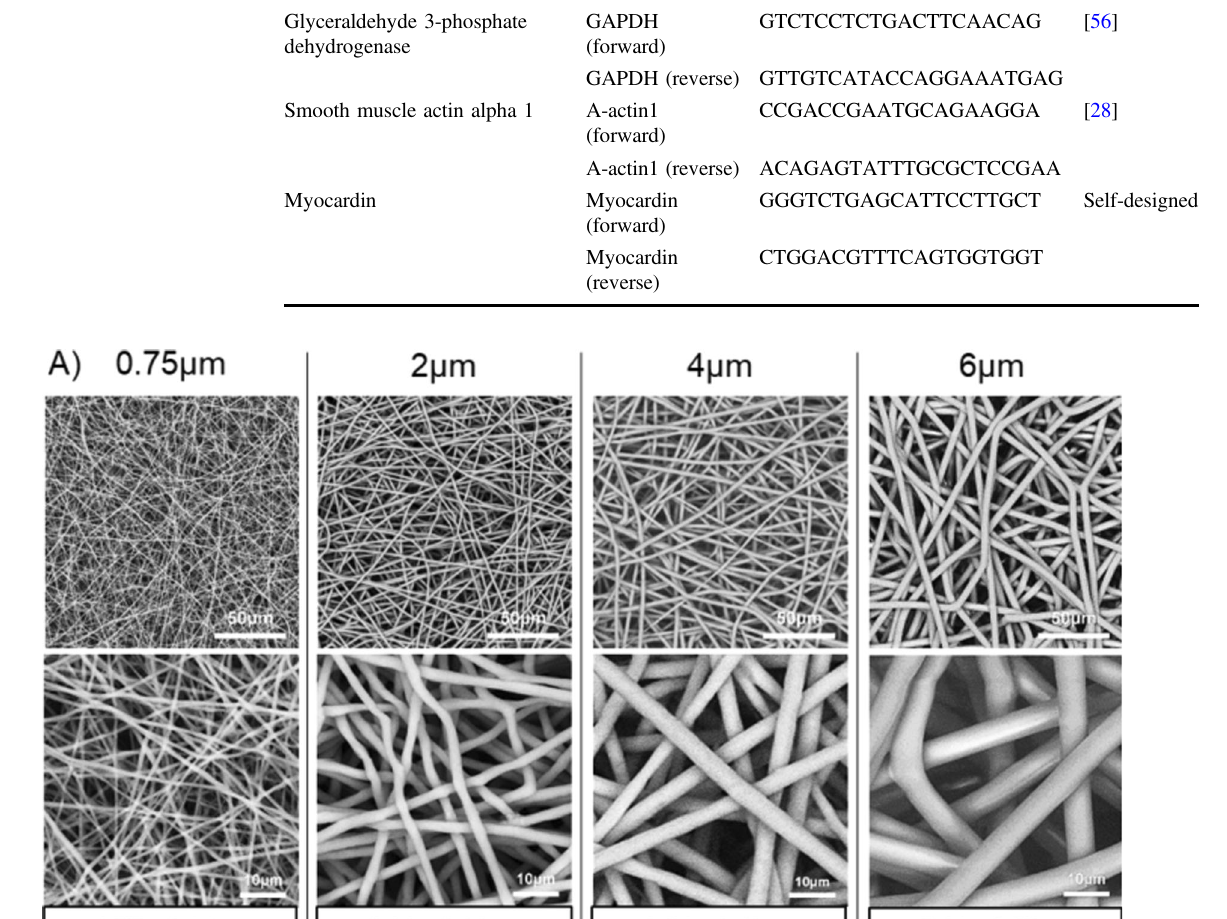
Table 2 Primer sequences used in RT-qPCR analysis